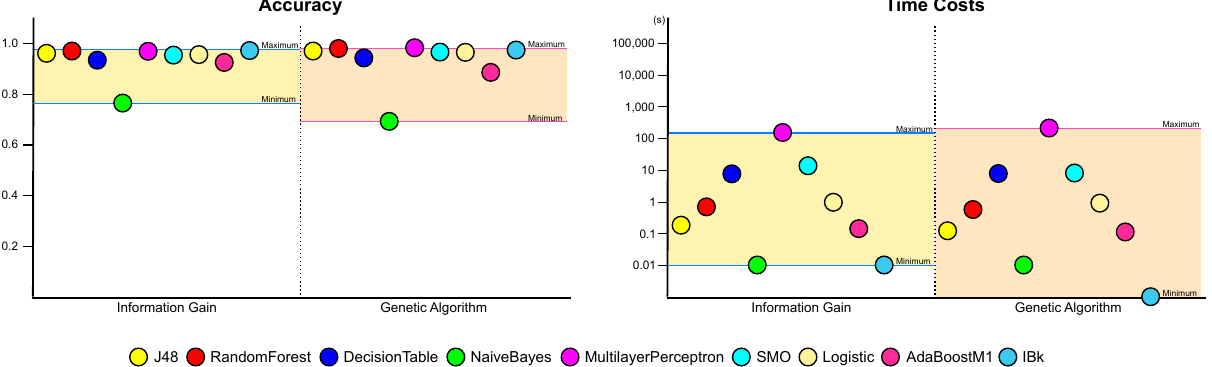
Figure 10. A comparison of machine learning performances between information gain-based and genetic algorithm-based feature selection. Table 8. Comparison with previous